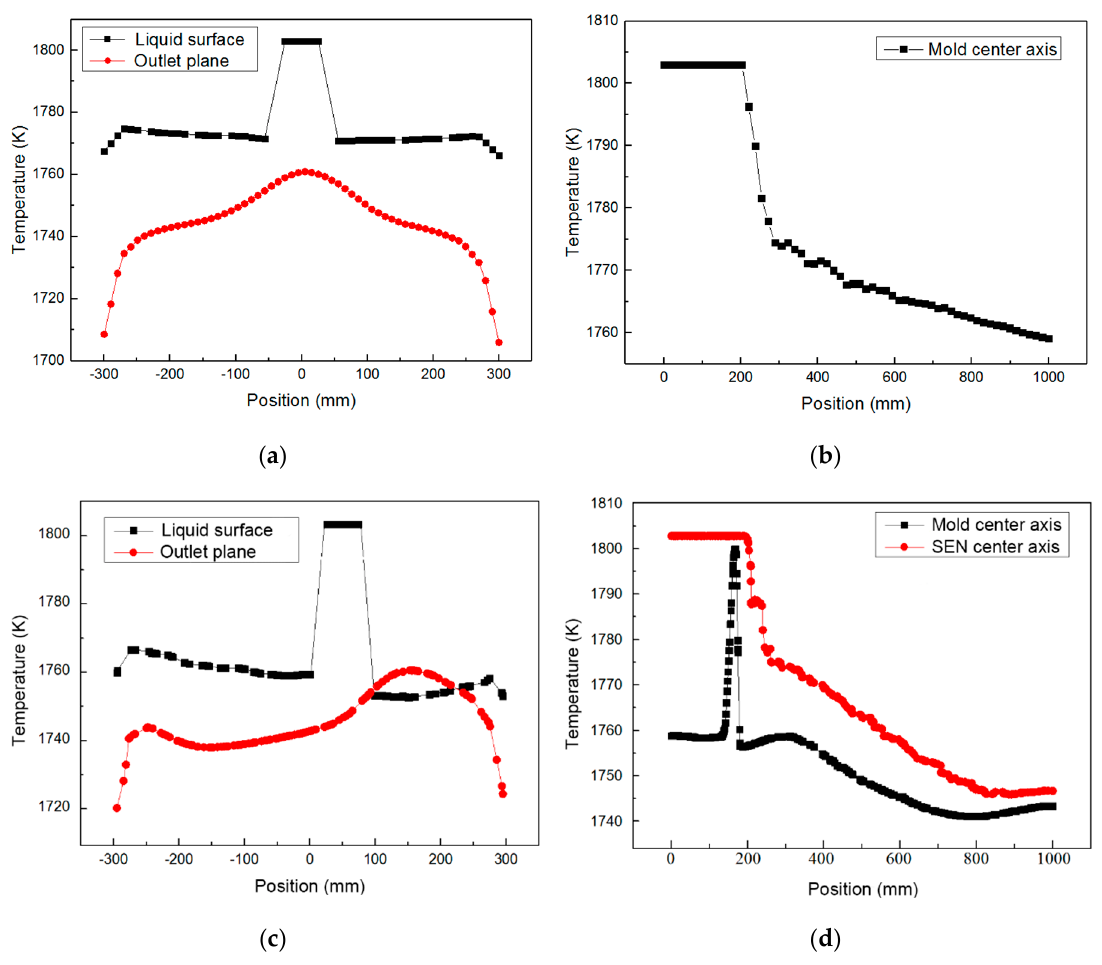
Figure 9. The effect of eccentric distance on the temperature field of mold when: ( a ) The temperature distribution along radial direction as the SEN eccentric distance is 0 mm; ( b ) The temperature distribution along central line as the SEN eccentric distance is 0 mm; ( c ) The temperature distribution along radial direction as the SEN eccentric distance is 50 mm; ( d ) The temperature distribution along.